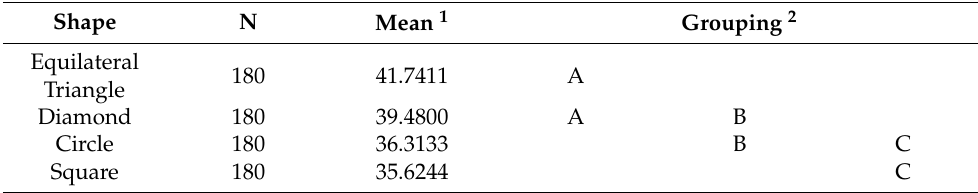
Table 10. Tukey post-hoc analysis for shape and perceived difficulty. The greatest difficulty was that of the equilateral triangle, and the least, that of the